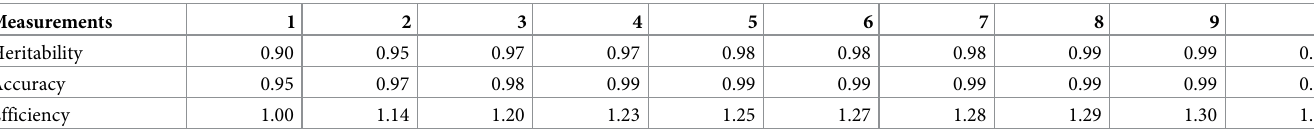
Table 1. Average heritability, accuracy, and efficiency based on different number of measurements for the severity of brown eye spot.